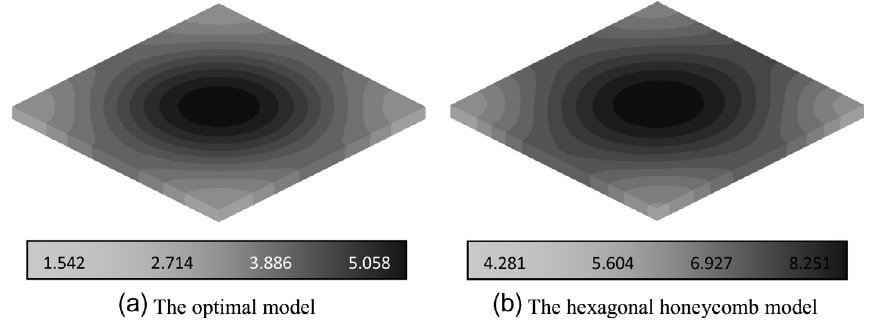
Figure 9. The deformation of the ceramic shell under pressure load (mm).